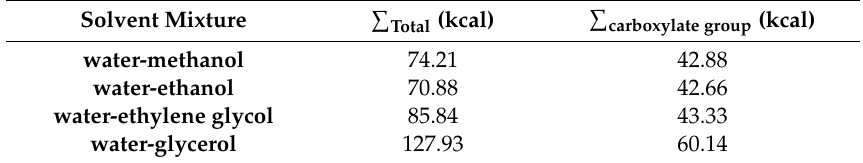
Table 4. Sum of the stabilization energies for all hydrogen bonds ( (cid:80) with the carboxylate group ( carboxylate group ) of the deprotonated gallic acid in the four solvent mixtures (1:1 water /